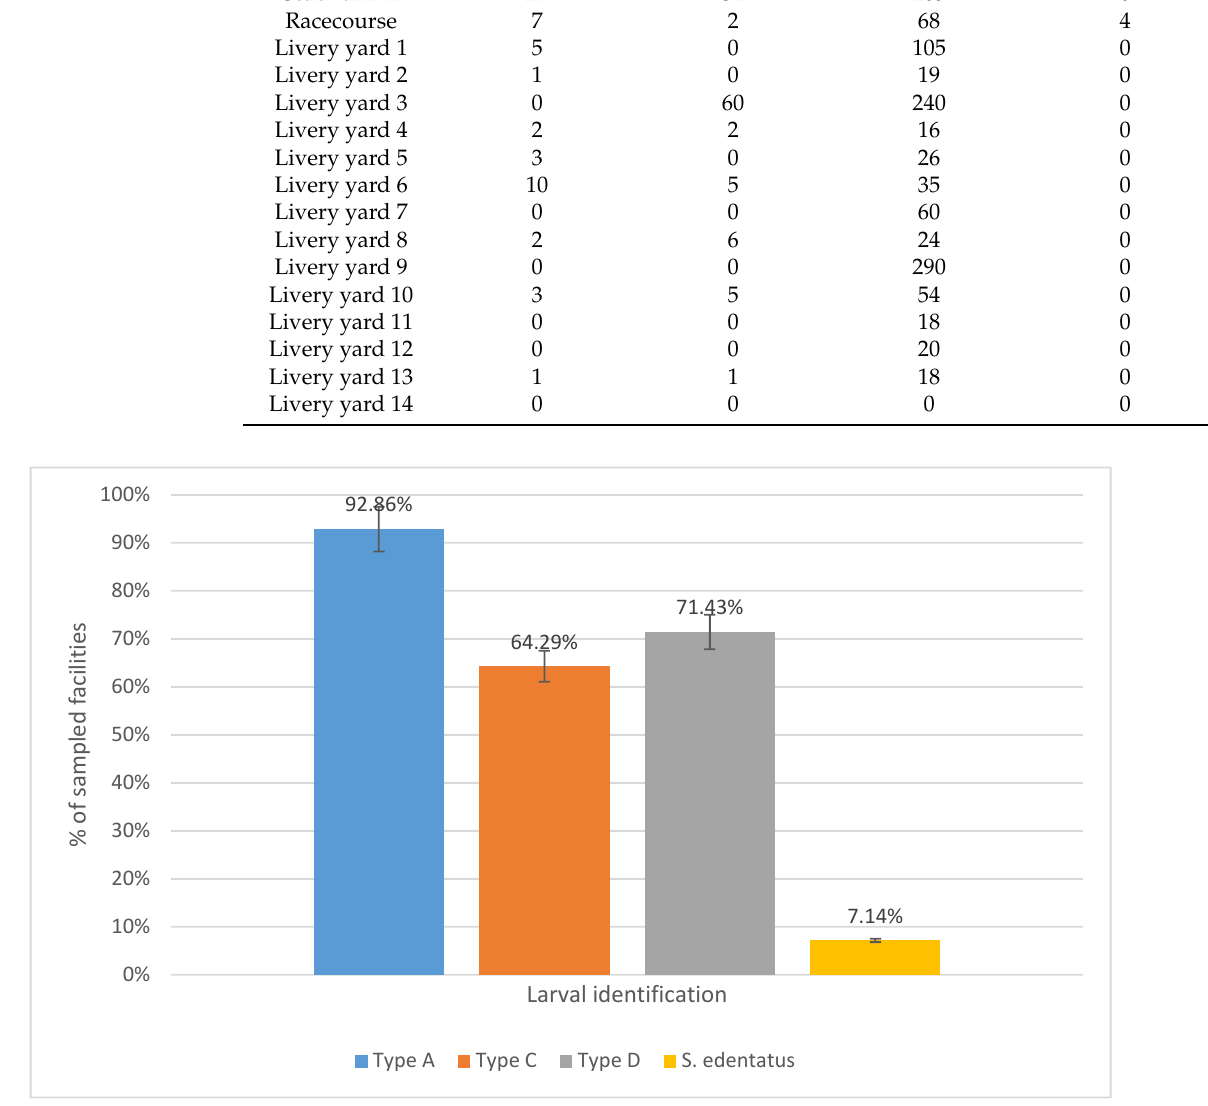
Figure 1. Total number (%) of facilities in which each of the identified larval types or S. edentatus were reported.